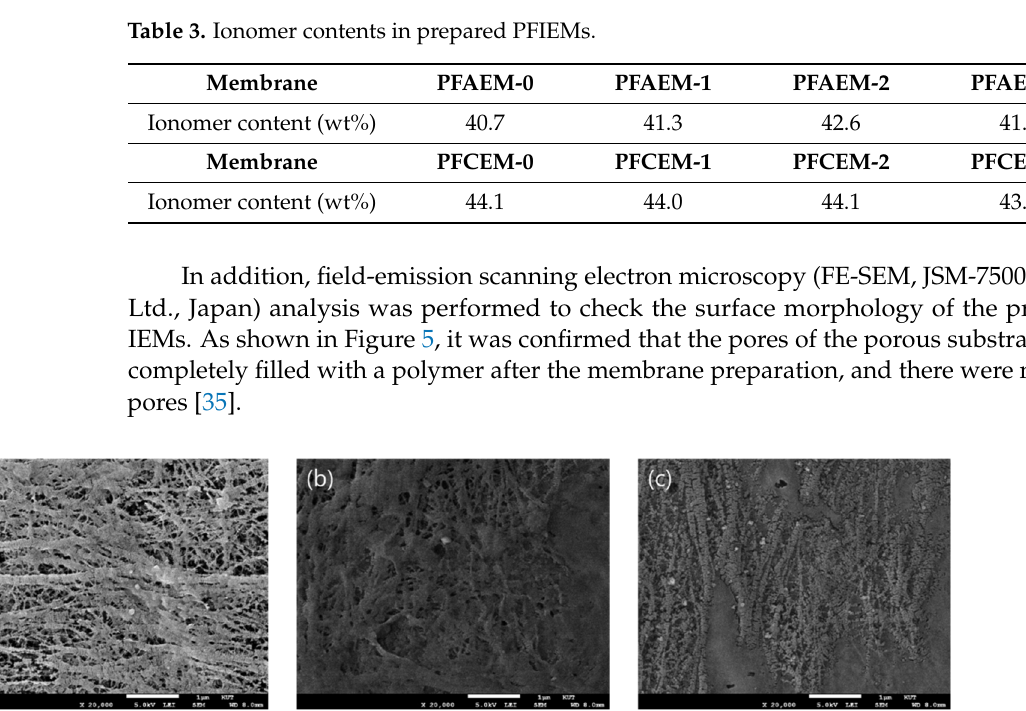
Figure 5. FE-SEM images (surface, ×20,000) of ( a ) porous PE substrate, ( b ) PFAEM-1, and ( c ) PFCEM-1.